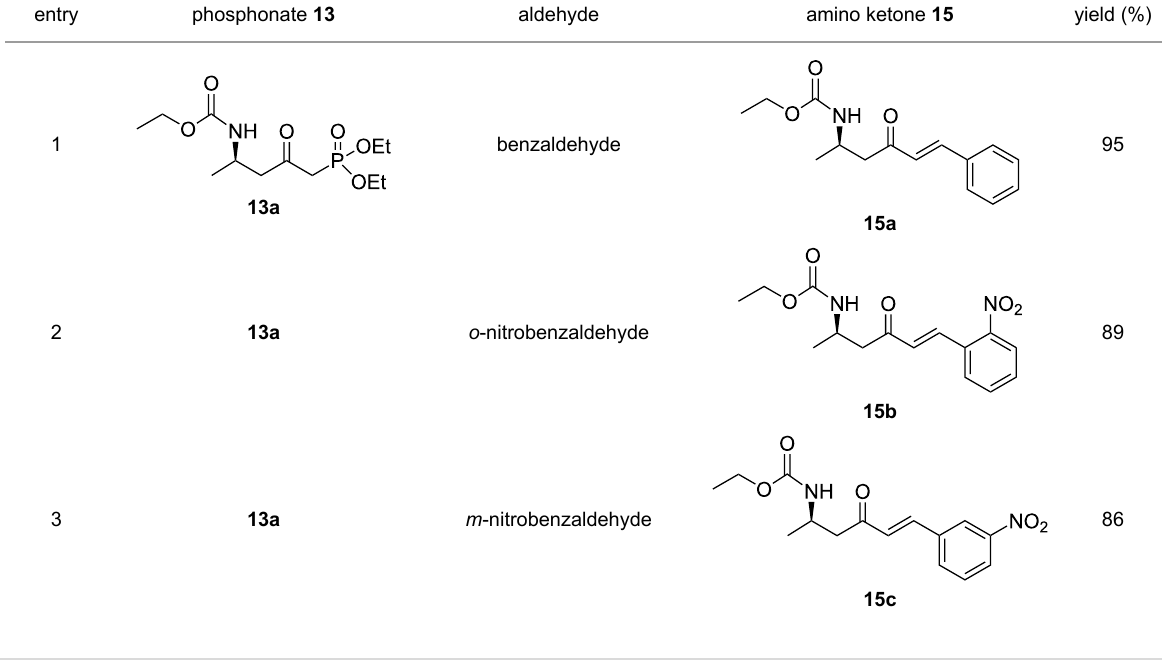
Table 3: Formation of the β ’-amino- α , β -unsaturated ketones 15 under Ba(OH) 2 conditions.